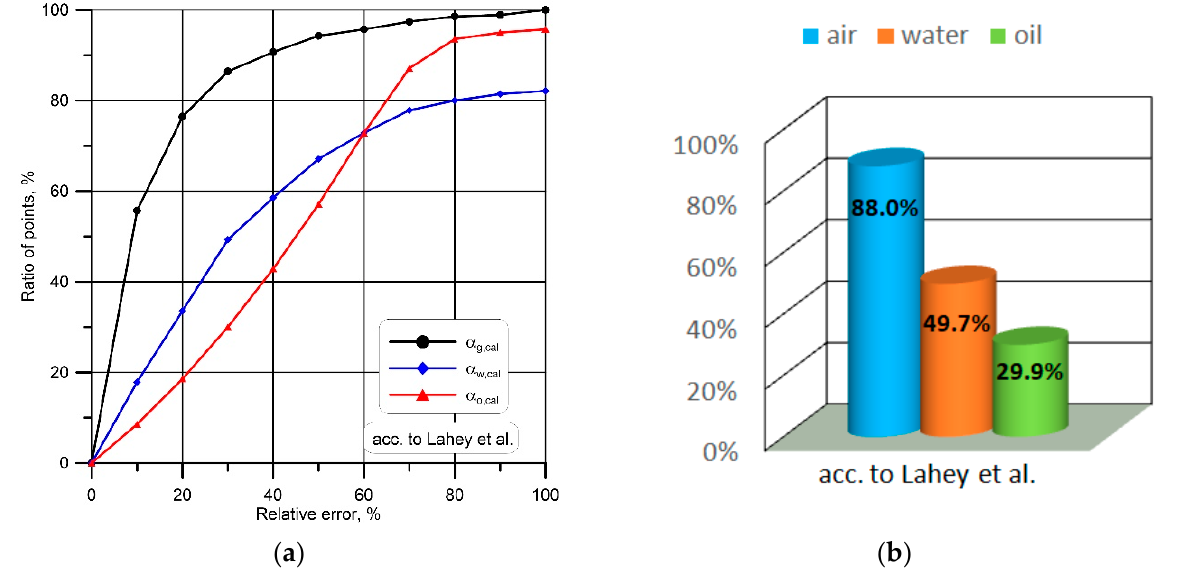
Figure 7. Analysis of method applied for determining the void and volume fraction of phases for downward three-phase oil–water–air flow ( a ), and ( b ) values of experimental points located within the boundary of <30% of the MAE of experimental points, in accordance with the Lahey et al. method [44].